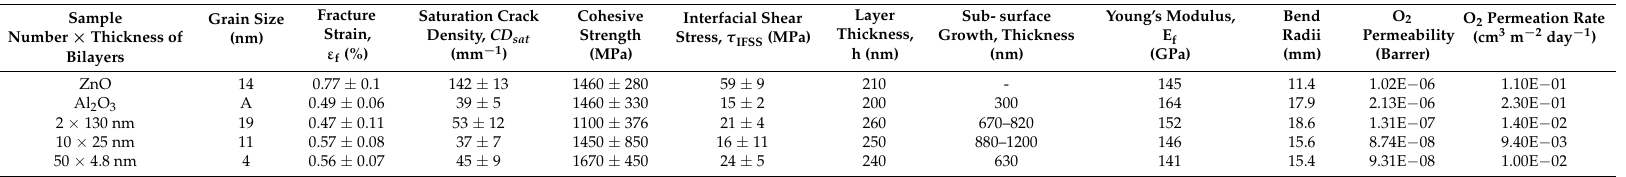
* Interfacial shear stress was calculated using the film thicknesses without considering the thickness of the sub-surface